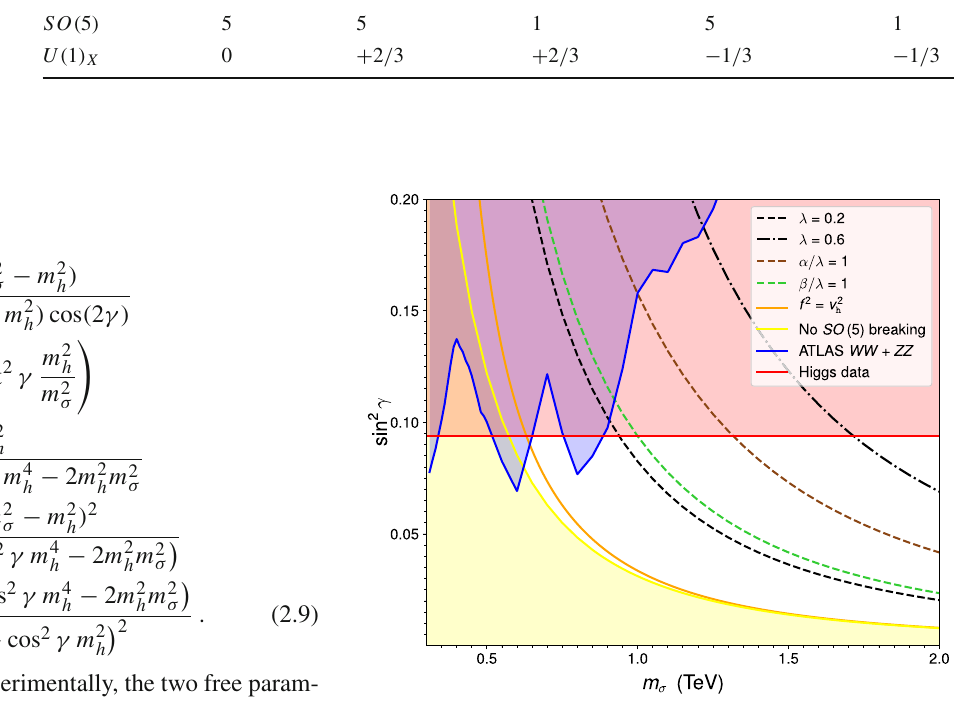
Fig. 1 Constraints on the mass ( m σ ) and mixing angle (sin 2 γ ) of the new singlet scalar σ (see text for